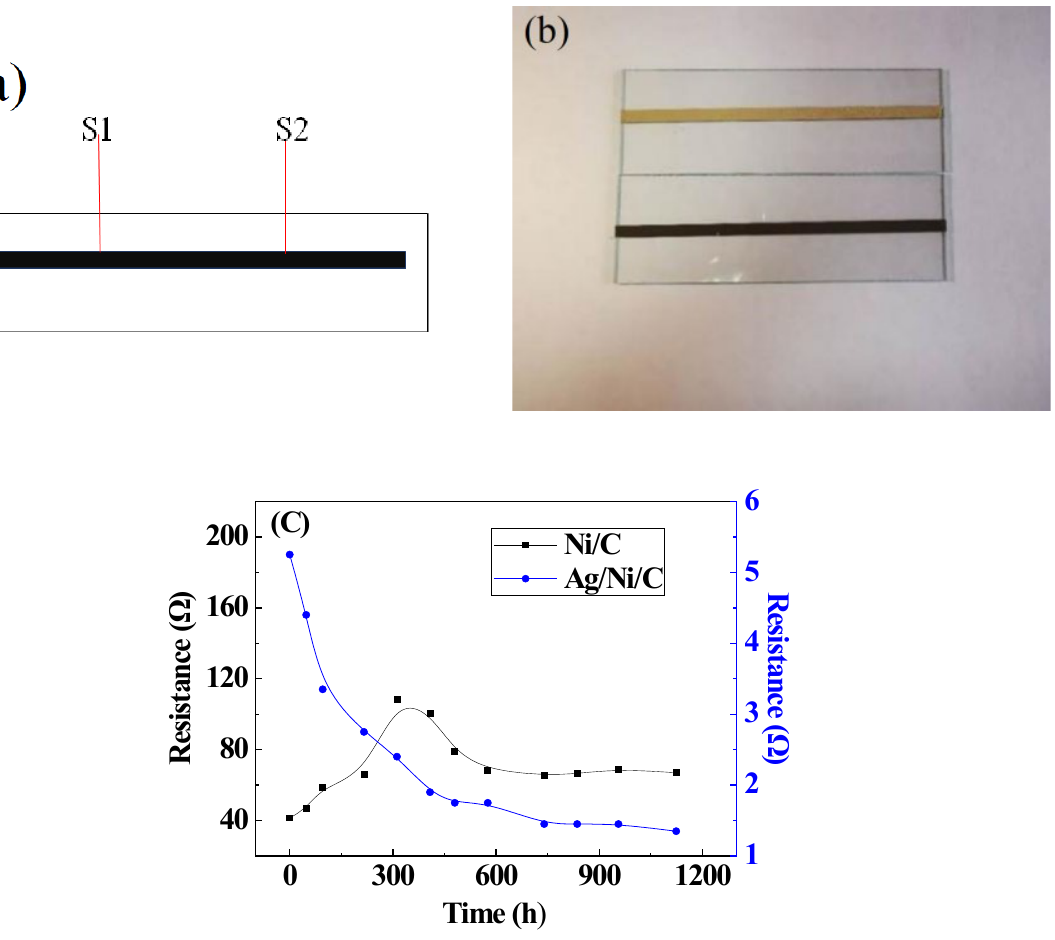
Figure 8 . Long-term conductivity tests of Ag/Ni/C and Ni/C powder-based membranes: ( a ) A sketch of the tested membrane; ( b ) Tested samples; ( c ) Conductivity tests.